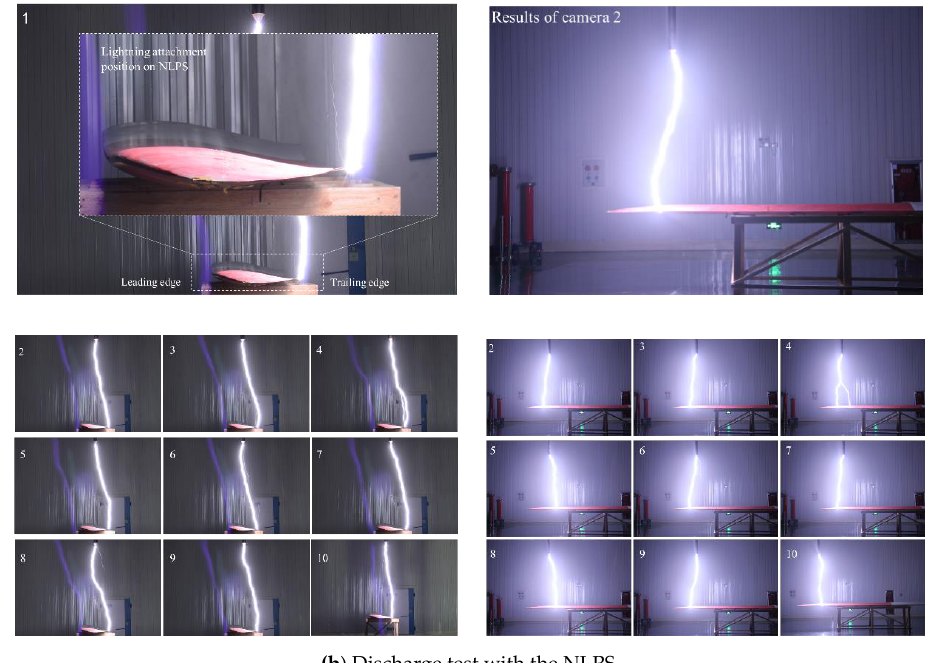
Figure 6. High voltage discharge test results.